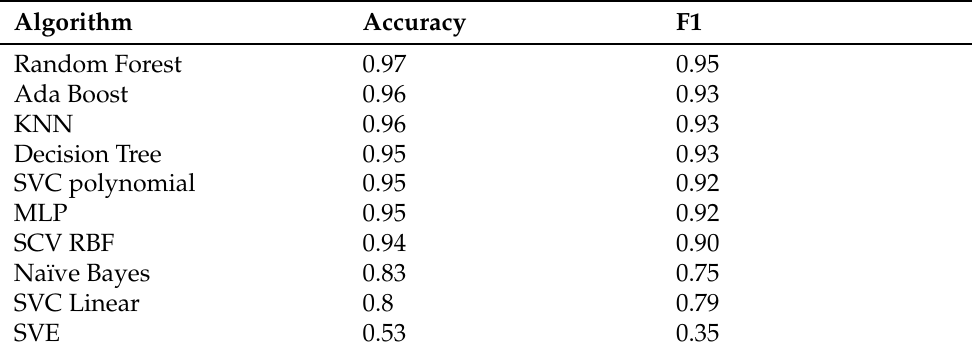
Table 3. SVE vs. machine learning algorithms [59].